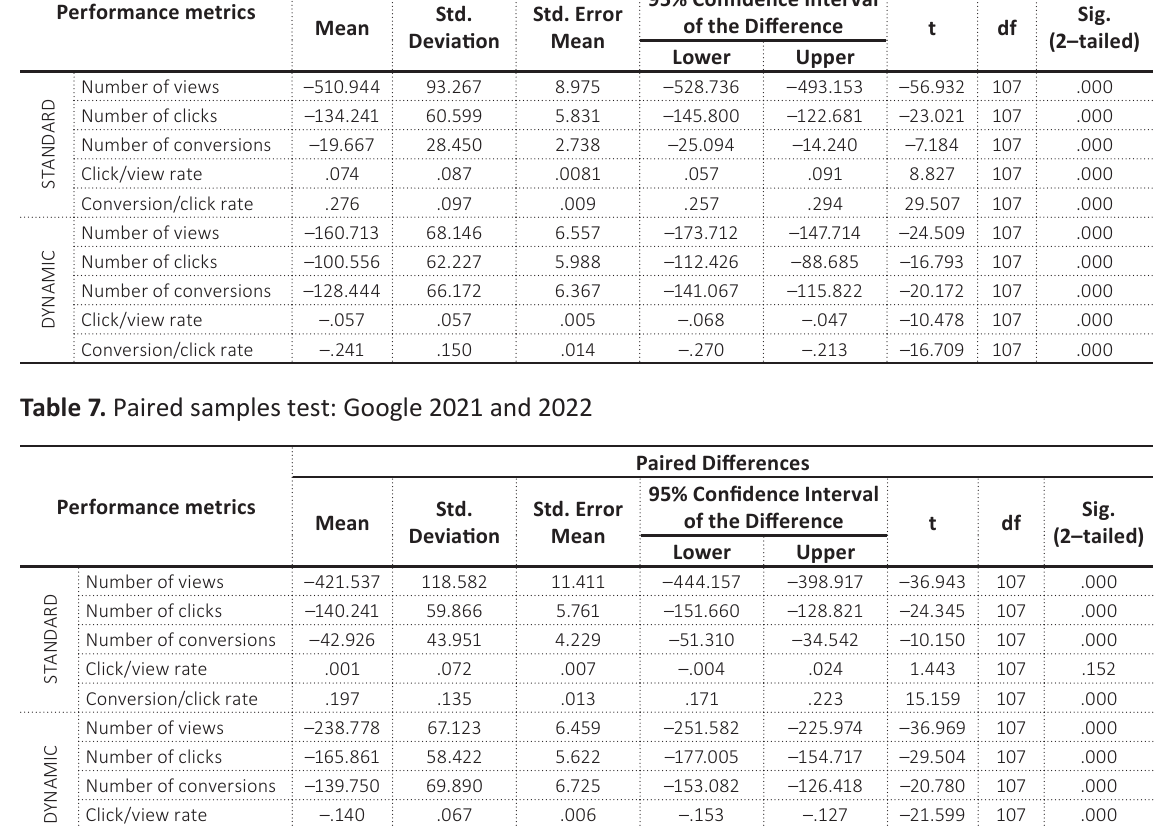
Table 6. Paired samples test: Meta 2021 and 2022 Performance metrics